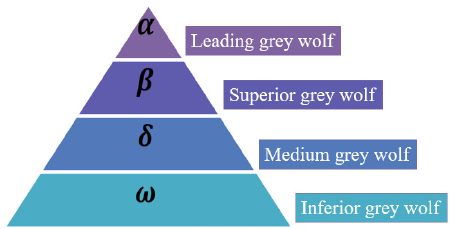
Figure 1. Extreme learning machine network structure.